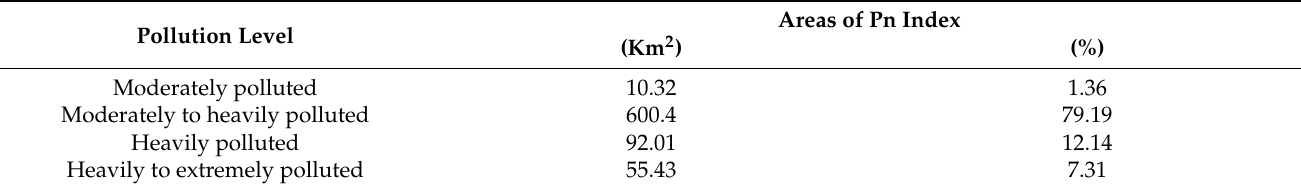
Table 4. Areas and contamination classes of Pn index.